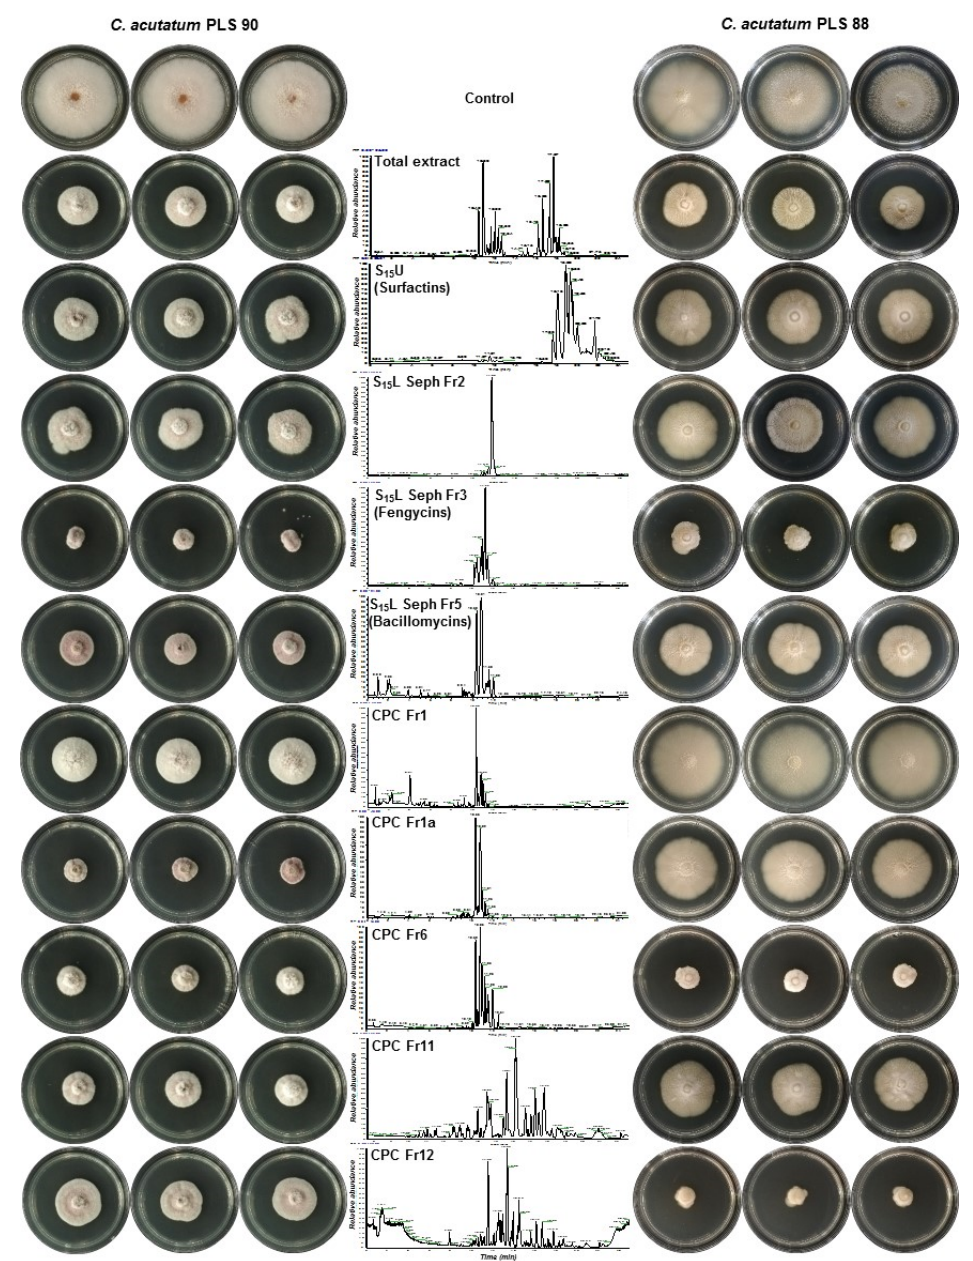
Figure 6. Effect of various fractions of the Bacillus sp. PTA13 total lipopeptide extract on the radial growth of the Colletotrichum acutatum species complex isolates PLS 90 (wild type) and PLS 88 (resistant to PPPs). The fractions were applied at concentrations equal to the EC 50 of the total LP extract for PLS 90 (27 μ g mL − 1 ) and PLS 88 (63 μ g mL − 1 ). Observations were taken 10 days post-treatment, and three biological replications were performed per treatment (CPC; Centrifugal Partition Chromatography, L; Lower Phase, S; Biphasic Solvent System, Seph; Sephadex, U; Upper Phase).